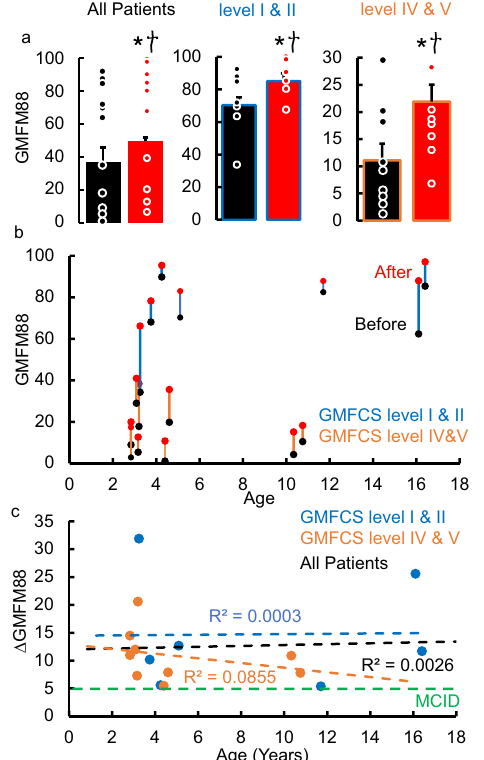
Fig. 2 | Primary outcome changes. a mean±SE ( n =16) GMFM-88 scores before and after therapy; mean±SE( n =7)GMFM-88 scores before(black) and after(red) therapy for GMFCS levels I and II (blue) and; mean±SE (n=9) GMFM-88 scores before (black) and after (red) therapy for GMFCS levels IV and V (orange). b GMFM88scoresatthestart(black)andendoftherapy(red)relativetoageofthe child at the start ofthe therapy and c Δ GMFM-88 scores relative to their age atthe start of the therapy. All data were tested for normality using the Kolmogorov- Smirnov test. Basedon the result of a normaldistribution, paired t-tests wereused to compare the group mean data before and after therapy. * Signi fi cantly different from before therapy at P < 0.05 . † Meaningful clinically improvement difference (MCID)=5 points. Source data are provided as a Source Data fi